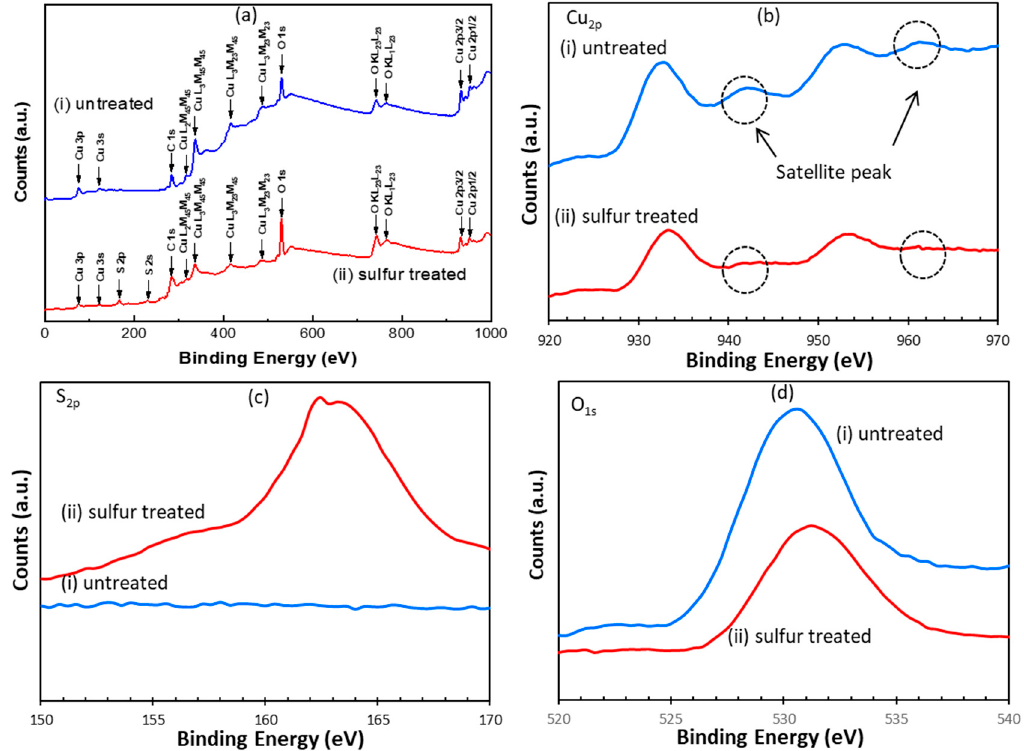
Figure 4. ( a ) The survey of the XPS spectra of (i) untreated n -Cu 2 O/ p -Cu 2 O homostructure and (ii) sulfur treated n -Cu 2 O/ p -Cu 2 O homostructure ( b ); the Cu 2p region of the XPS spectra of (i) untreated n -Cu 2 O/ p -Cu 2 O homostructure and (ii) sulfur-treated n -Cu 2 O/ p -Cu 2 O homostructure; ( c ) the XPS spectra of S 2p, (i) untreated n -Cu 2 O/ p -Cu 2 O homostructure, and (ii) sulfur-treated n -Cu 2 O/ p -Cu 2